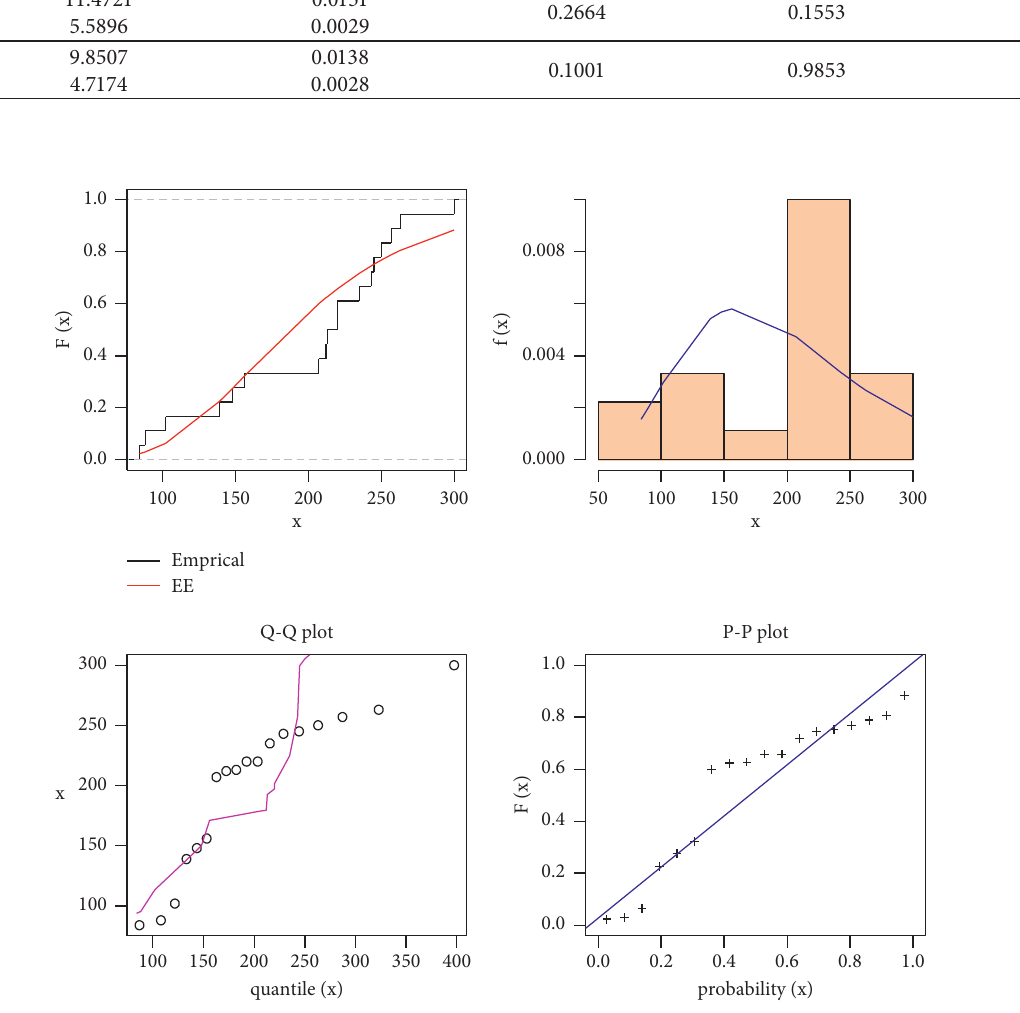
Figure 3: The fitted pdf, cdf, PP plot, and QQ plot for EE distribution for the first